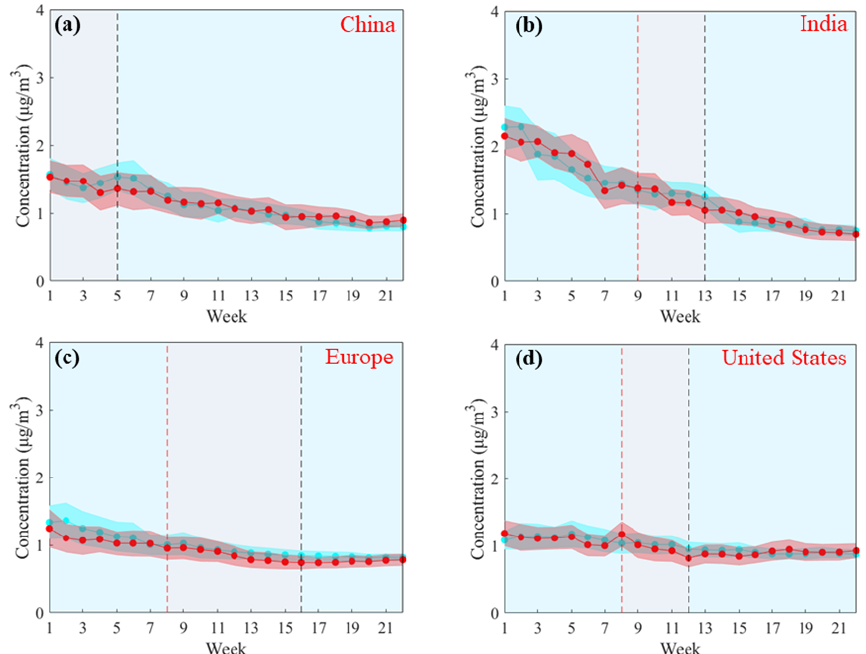
Figure 3. The weekly variations in atmospheric benzene concentrations (µgm − 3 ) in some major regions around the world during 23 January– 30 June. The red line and background denote mean values and standard deviation of deweathered weekly benzene concentrations in 2020. The cyan line and background denote mean values and standard deviation of deweathered weekly benzene levels in 2019. The dashed vertical red line indicates COVID-19 restriction dates, and the dashed vertical black line indicates the beginning of easing